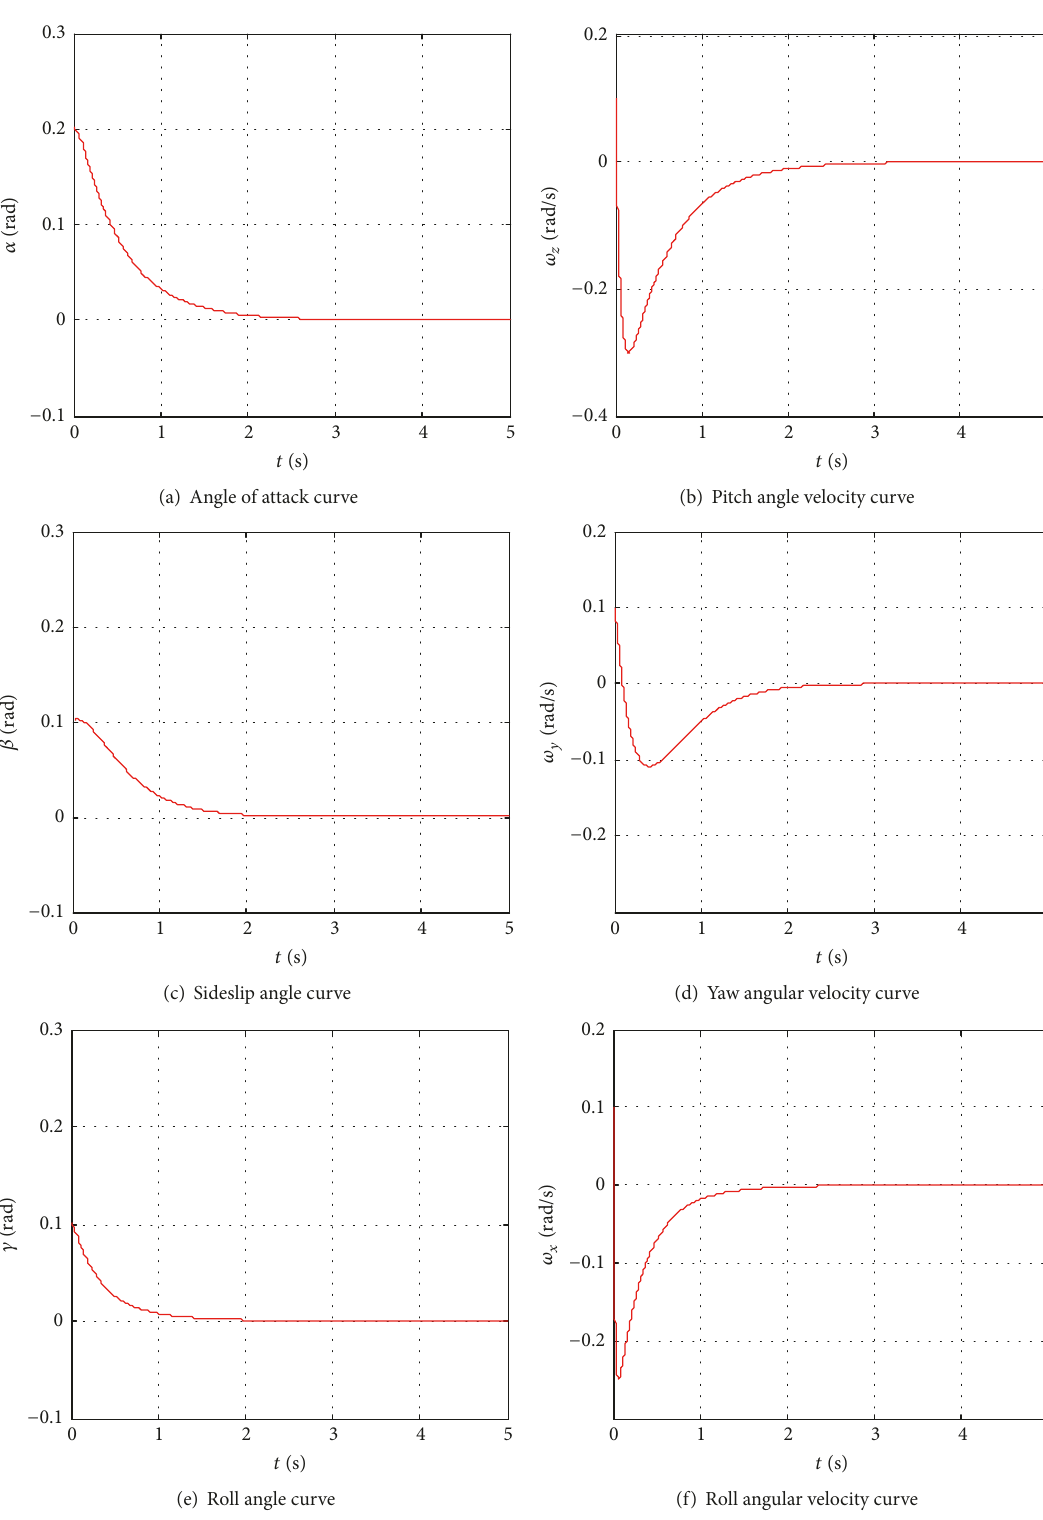
Figure 2: Responses of GCC